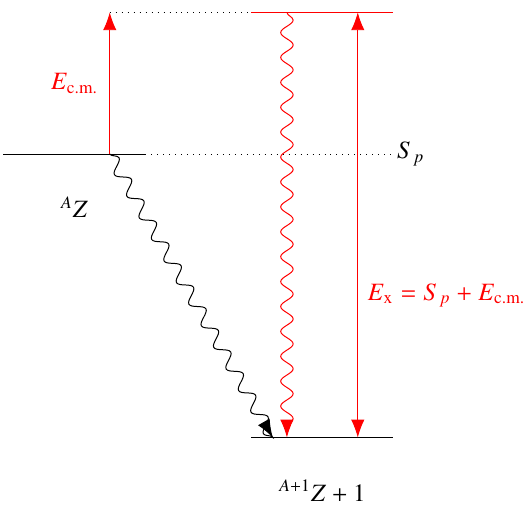
Figure 2. Schematic diagrams showing the (black) direct-capture mechanism and (red) resonance- capture mechanism for proton capture onto a target nucleus A Z to the ground state of the residual nucleus, A + 1 Z + 1. The excitation energy of the resonance state of importance for the reaction is given by the sum of the proton separation energy, S p , and the centre-of-mass energy of the colliding system, E c . m .